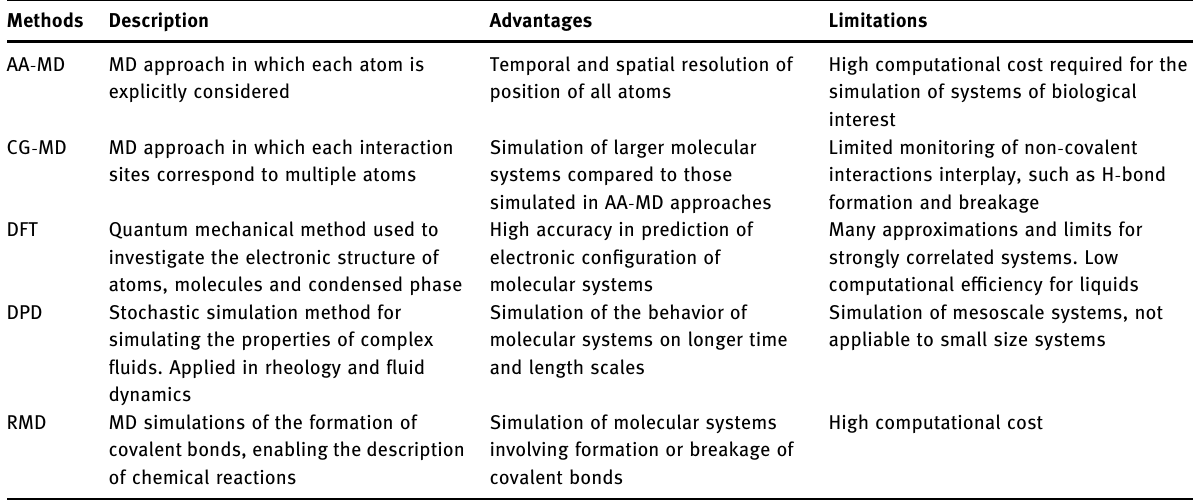
Table 2: Main MD simulation methods described in this review Methods